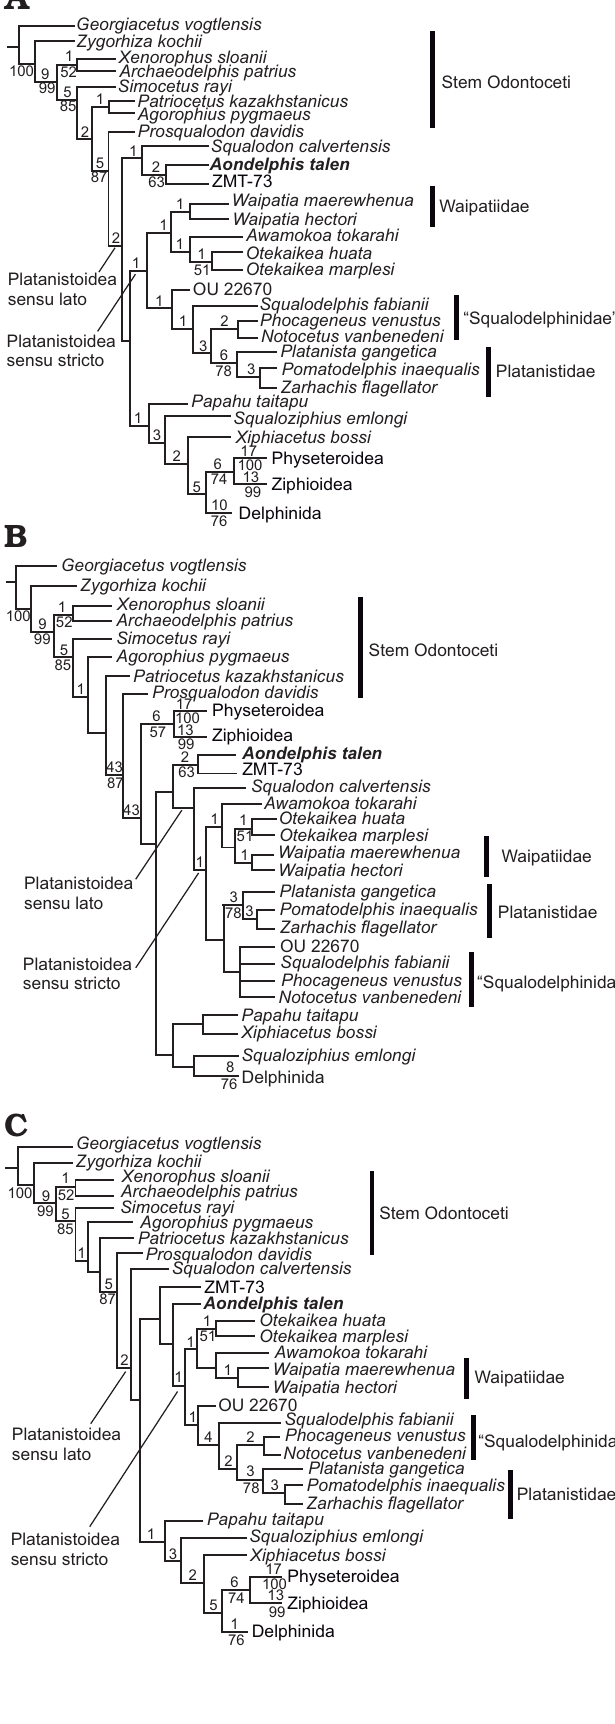
Fig. 7. Strict consensus trees of the phylogenetic analysis under equal weights ( A ), and implied weights with K = 3 ( B ) and K = 4 ( C ) obtained in the present study. Numbers above branches indicate Bremer support, whilst number below branches indicate jackknife support using p = 0.30 and 1000 pseudoreplicates. Delphinida sensu Geisler et al. (2011) were collapsed for ease of